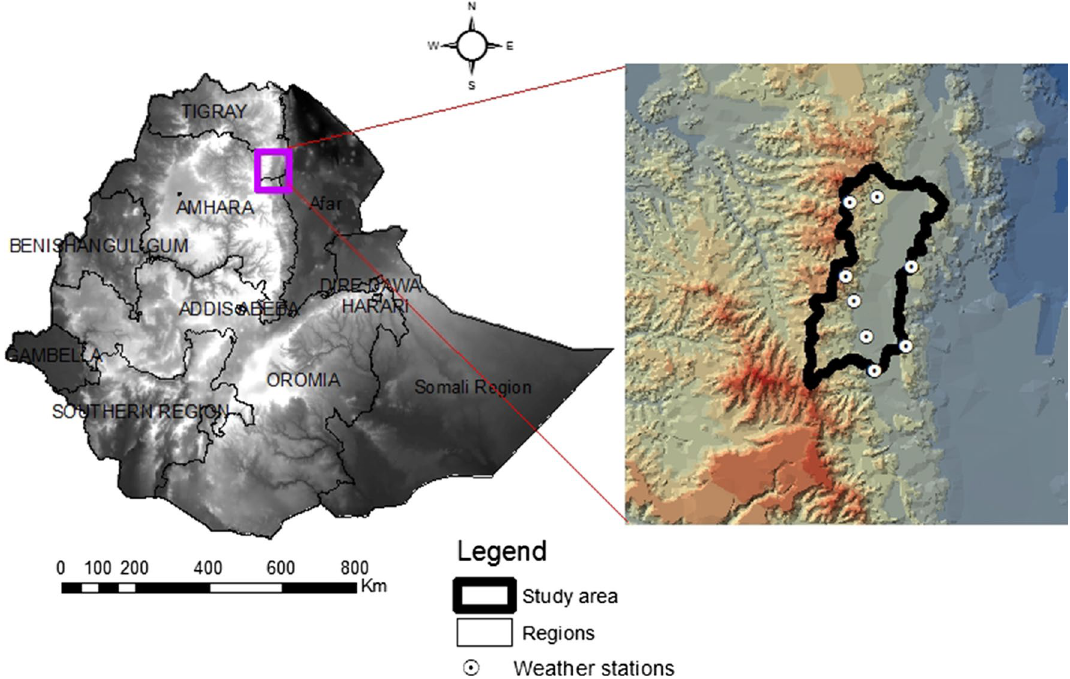
Fig. 1 Location map of the study